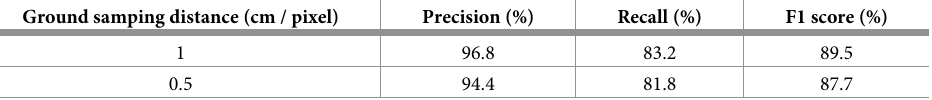
Table 2. Feeding trail extraction for the input images of different ground sampling distances (precision, recall, and F1 score). Ground samping distance (cm / pixel)